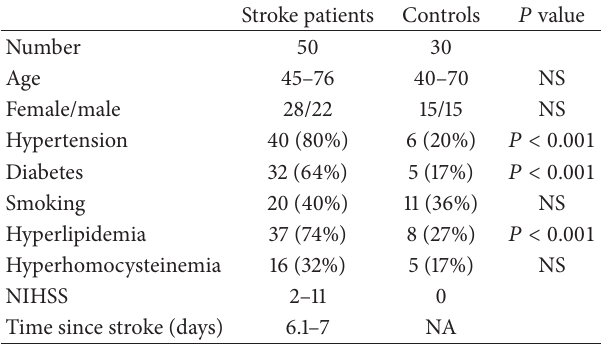
Table 1: Clinical characteristics of the controls and stroke